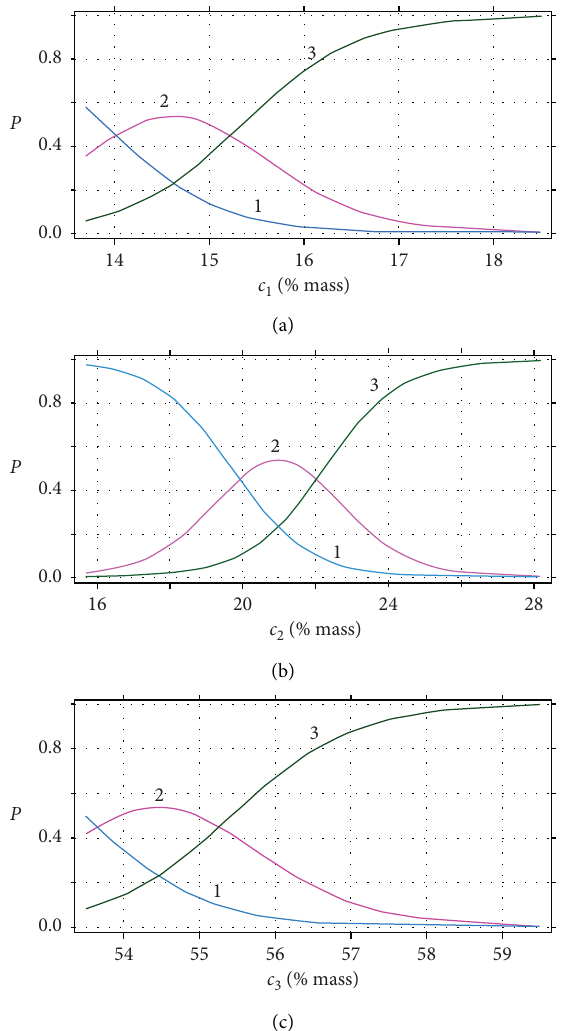
Figure 2: Probabilities P of responses of diferent appearance categories in dependence on content of (a) protein c moisture c 3 , mass fractions, %. Each plot is calculated at contents of other main components equal to their observed mean values (Table 4). Line 1 is for the category “satisfactory,” line 2 for the category “good,” and line 3 for the category